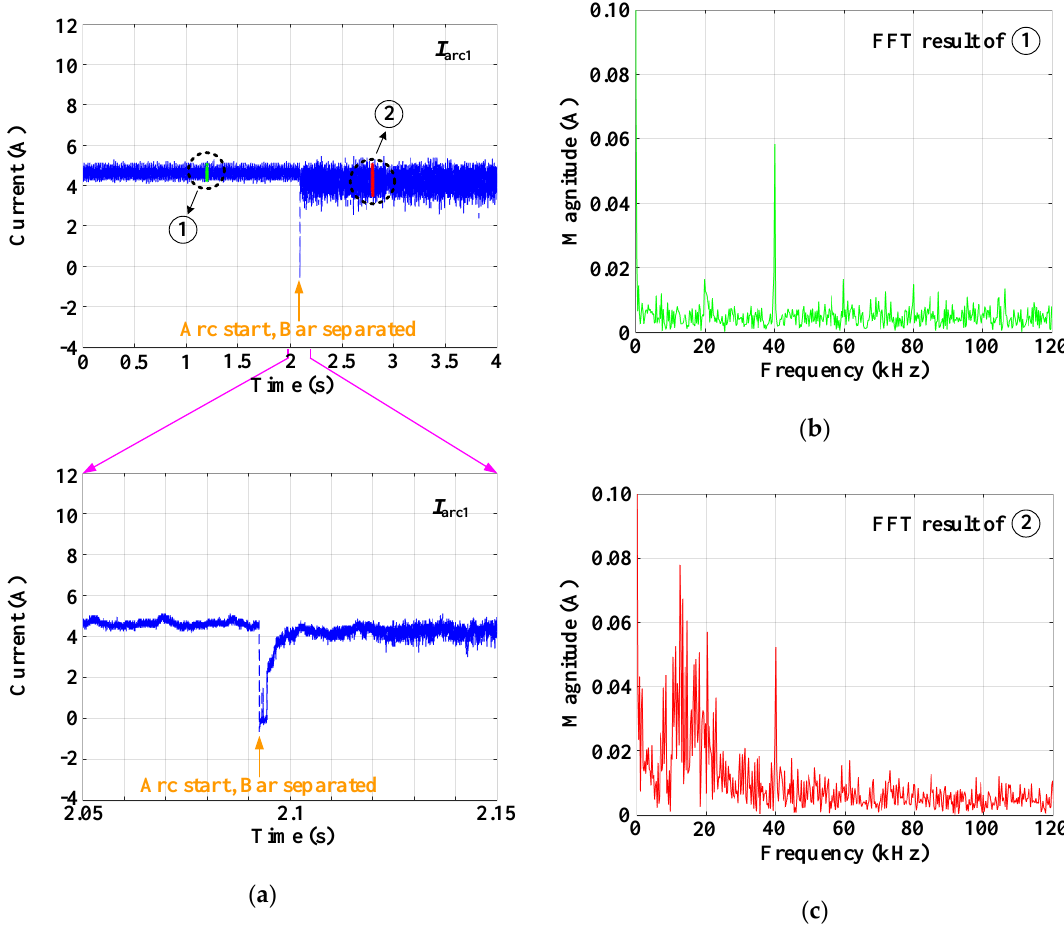
Figure 3. Current waveform and FFT results of 𝐼 𝑎𝑟𝑐1 when the magnitude of current is 5 A and switching frequency is 20 kHz: ( a ) current waveform, ( b ) FFT result before arcing, and ( c ) FFT result after arcing.